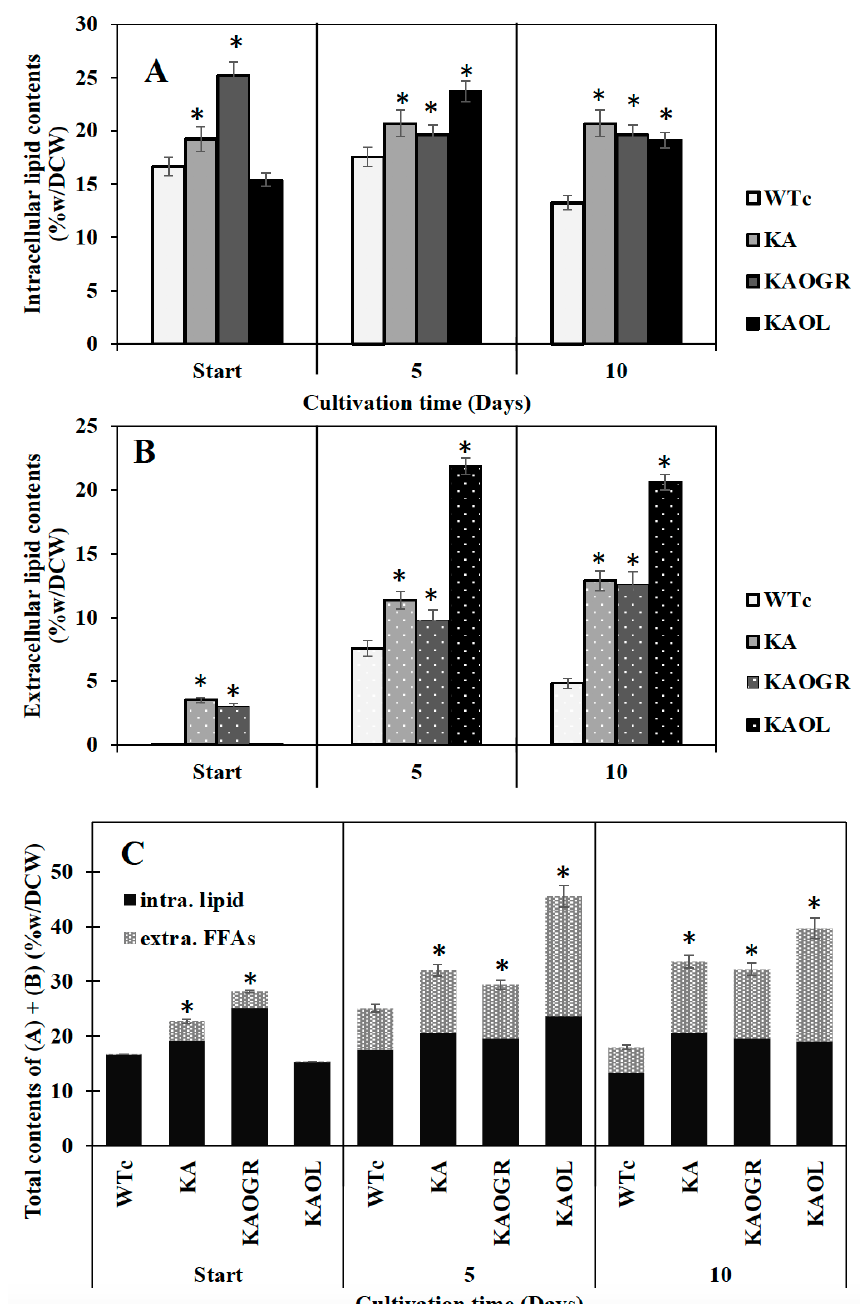
Figure 5. Contents (%w/DCW) of intracellular lipid ( A ) and extracellular FFAs ( B ) and total contents of intracellular lipid and extracellular FFAs ( C ) in Synechocystis PCC 6803 strains WTc, KA, KAOL and KAOGR. Cells were grown in BG 11 medium at the start of the experiment (day 0) and analysed at days 5 and day 10 of cultivation. Error bars represent standard deviations of means (mean ± S.D., n = 3). The statistical differences of the results between the WTc and engineered strains are indicated by an asterisk *, p < 0.05.